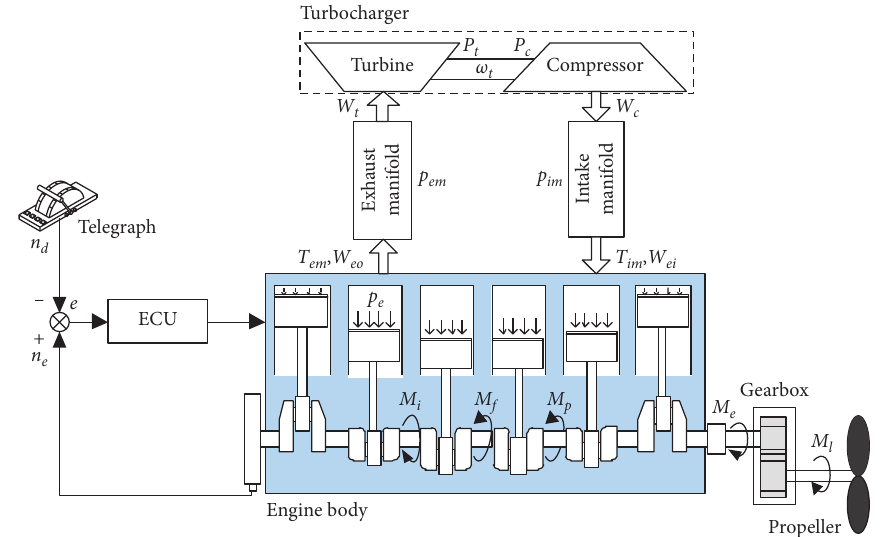
Figure 1: Structure of the marine diesel engine in a